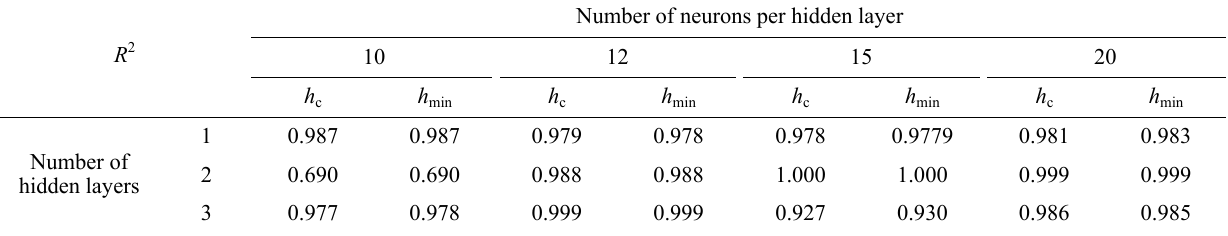
Table 7 Coefficients of determination for the prediction of the central and minimum film thicknesses for the infinite 2D line contact against testing data using ANNs with variable numbers of hidden layers and neurons per hidden layer.